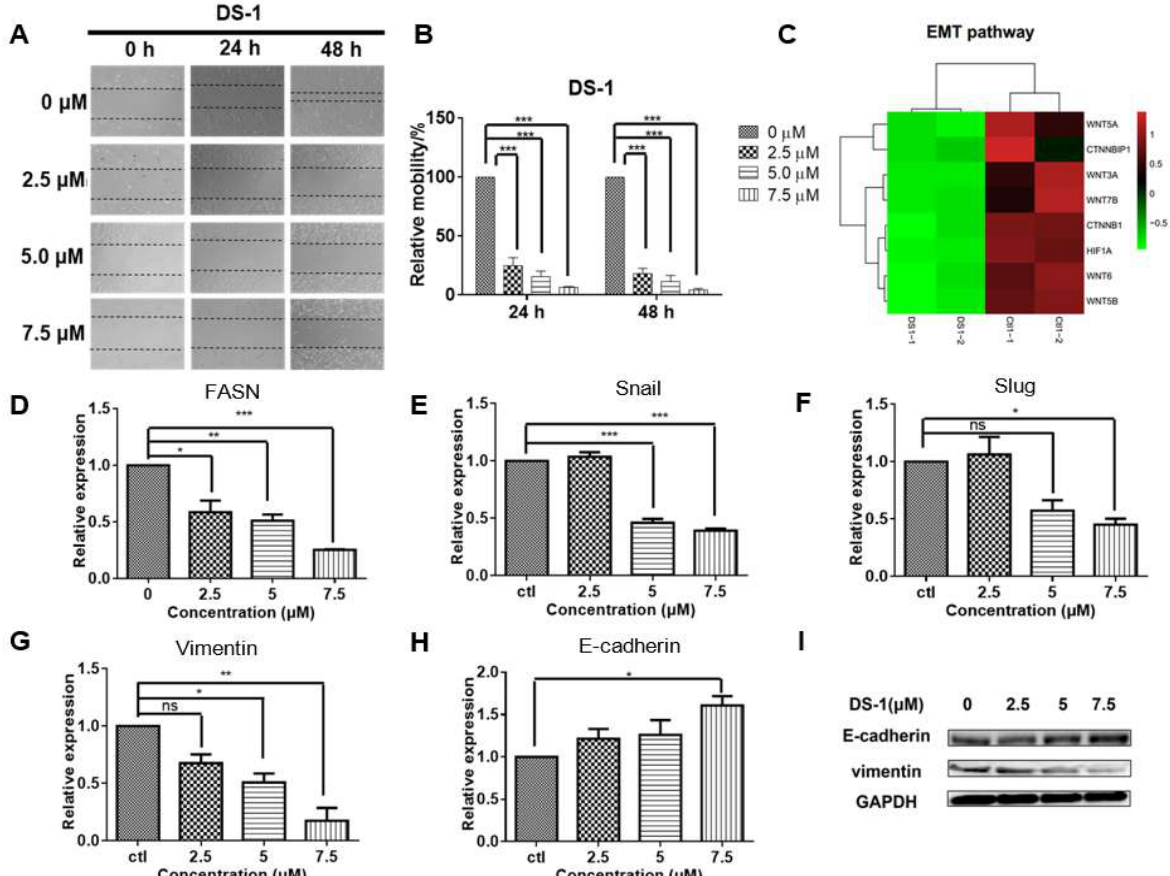
Figure 6. DS − 1 inhibited cell migration of U − 2 OS cells. ( A , B ) U − 2 OS cells were cultured to the logarithmic growth phase; the cell monolayers were scratched by pipet tips, and DS − 1 at 0, 2.5, 5, and 7.5 µM was added to the plate for 24 and 48 h, respectively. Cell migration was recorded at the same location of the scratch. Data of relative mobility are shown as the mean ± S.D. from three independent experiments. *** p < 0.005. ( C ) The expressions of several genes regulating EMT signals from the transcriptome result are shown in the heatmap. ( D – H ) U−2 OS cells were treated with DS−1 at 2.5, 5.0, and 7.5 µM for 24 h, and the relative expression of FASN, snail, slug, vimentin, and E-cadherin mRNA are shown in histograms. Values are the average of three independent experiments; * p < 0.05, ** p < 0.01, *** p < 0.005. ( I ) EMT marker molecules E-cadherin and vimentin were analyzed by Western blot.